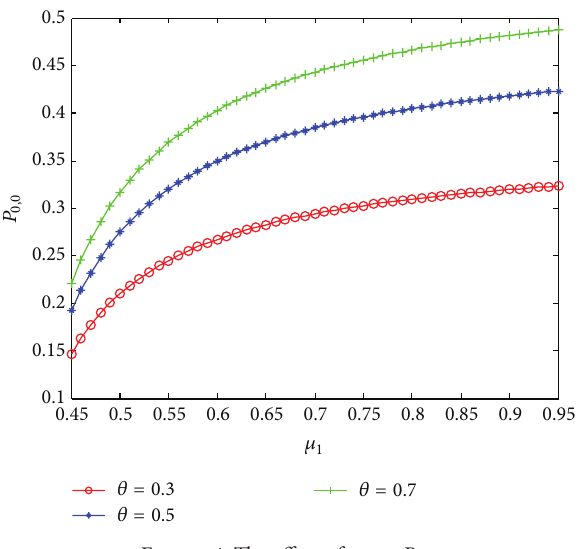
Figure 4: The effect of 𝜇 1 on 𝑃 0,0